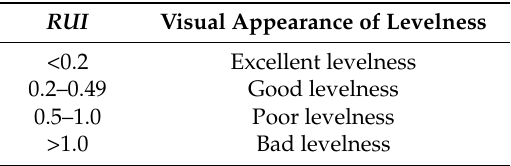
Table 2. Suggested interpretations of RUI values [13].